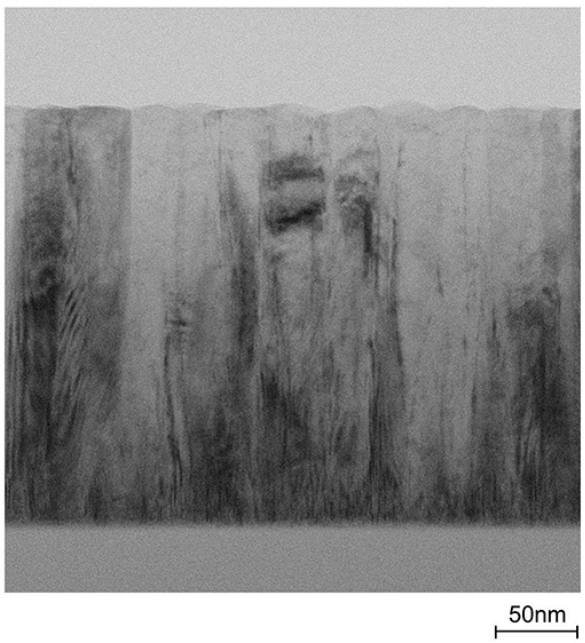
Figure 2. A cross-sectional TEM image of an as-deposited ZnO:Al (2.0 wt %) film.